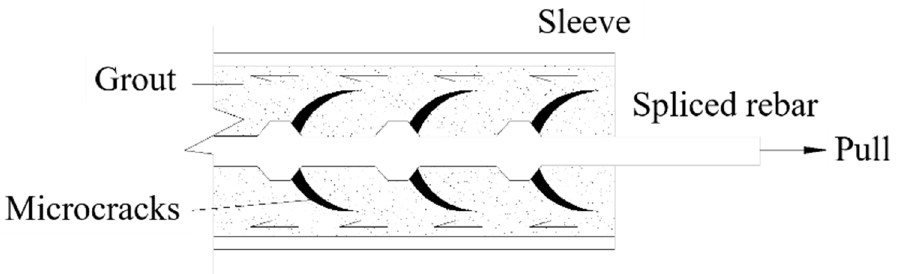
Figure 8. Crack expansion of grout.